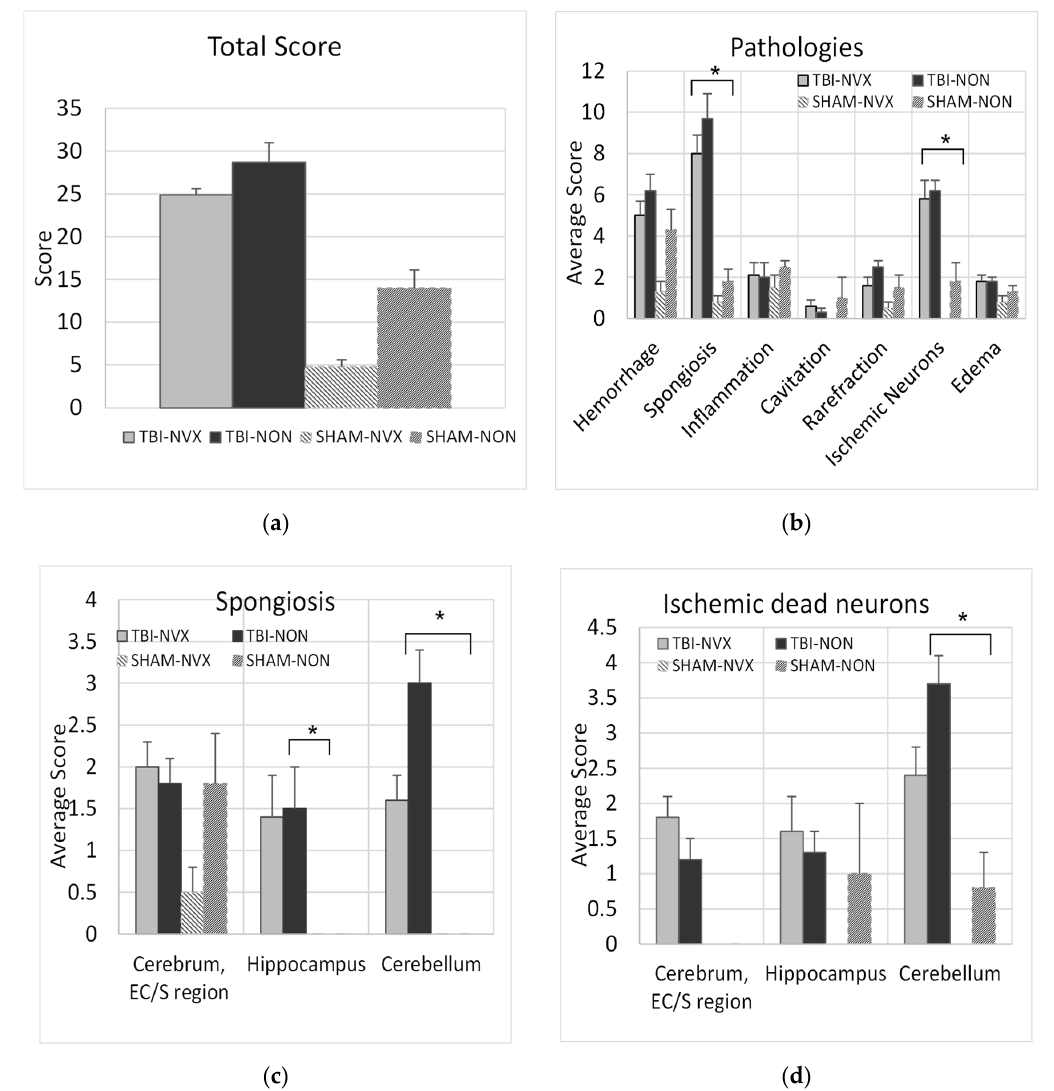
Figure 5. Pathology scores for various sections of the brain. ( a ) Global injury score from each pathology detected in brain sections (mean ± SEM) for all brain regions in swine with or without traumatic brain injury (TBI, SHAM, respectively) that received NVX-428 (NVX) or normal saline (NON) at 15 min after baseline and euthanized 360 min after baseline. ( b ) Break down from the various brain pathologies observed in different groups. ( c ) Specific regional injury scores for spongiosis and ( d ) ischemic/dead neurons (mean ± SEM) using Hematoxylin and Eosin (H&E) staining. EC/S = entorhinal cortex/subiculum. * p < 0.01 significance between SHAM and TBI groups.